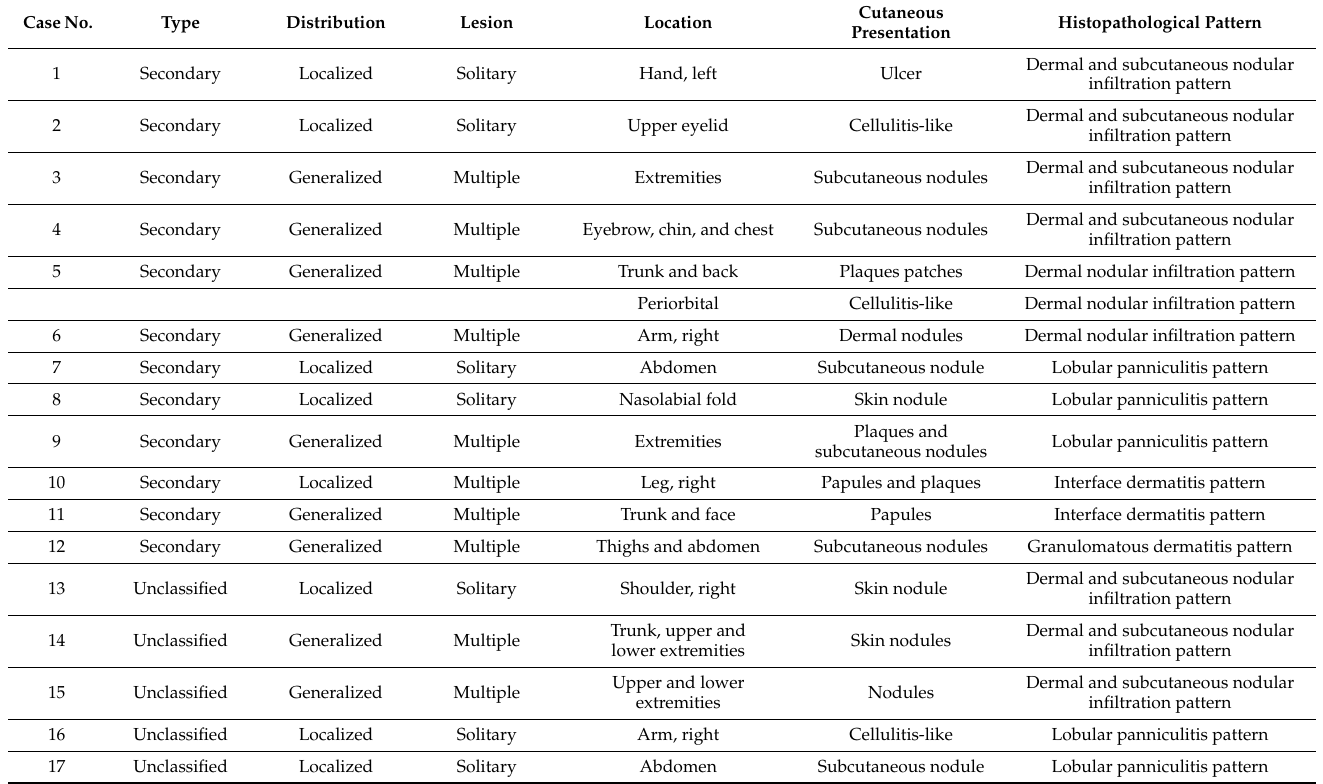
Table 2. Clinical skin manifestations and histopathological